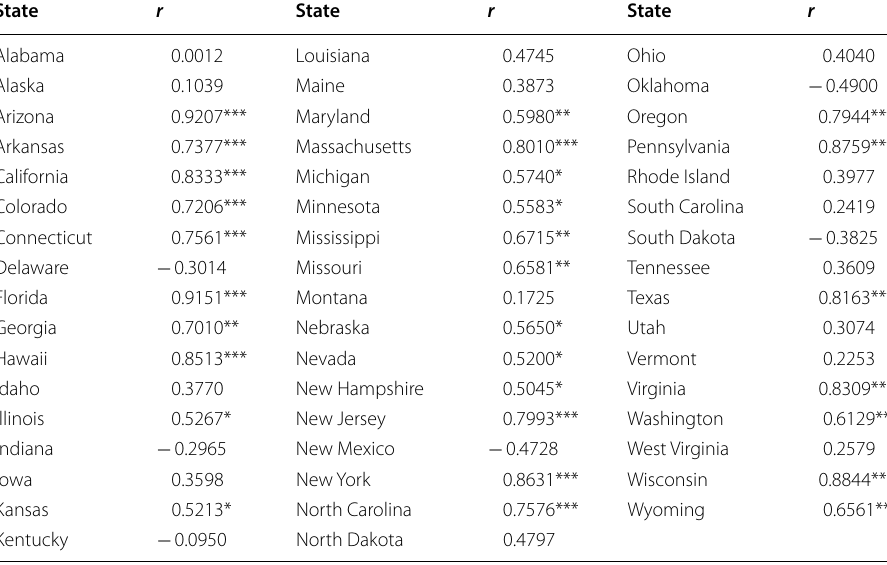
Table 9 Correlations between Google Trends data and Hepatitis cases by state